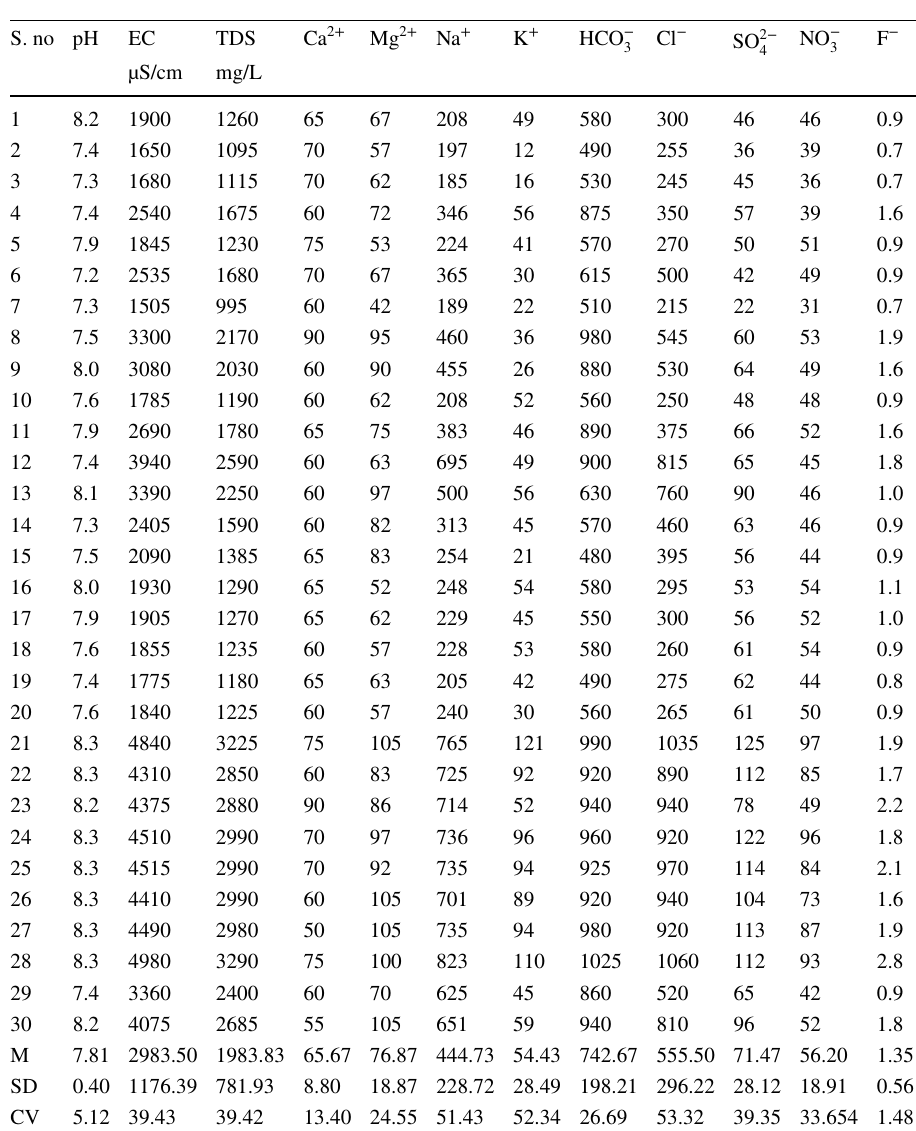
M mean, SD standard deviation, CV coefficient of